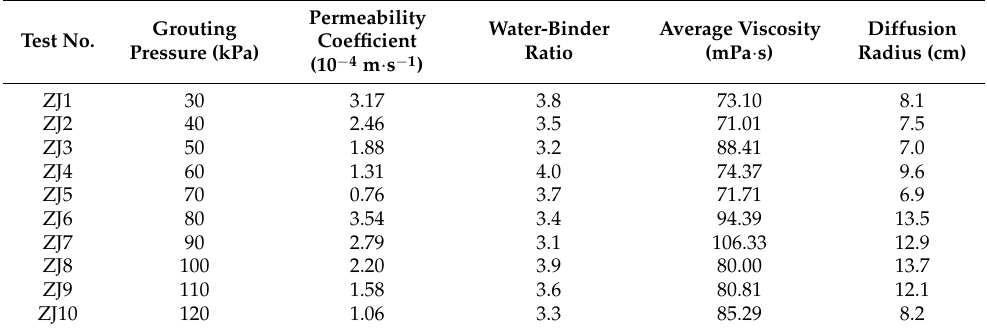
Table 1. Grouting parameters and test